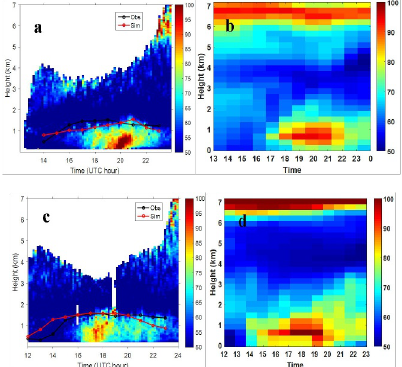
Fig. 3 Spatial and temporal distribution of O 3 mixing ratio (ppbv) at Westport (red line: simulated PBL height; black line: observed PBL height at CCNY on 28, 29 August 2018 (a and c: ozone lidar; b and d: WRF/Chem